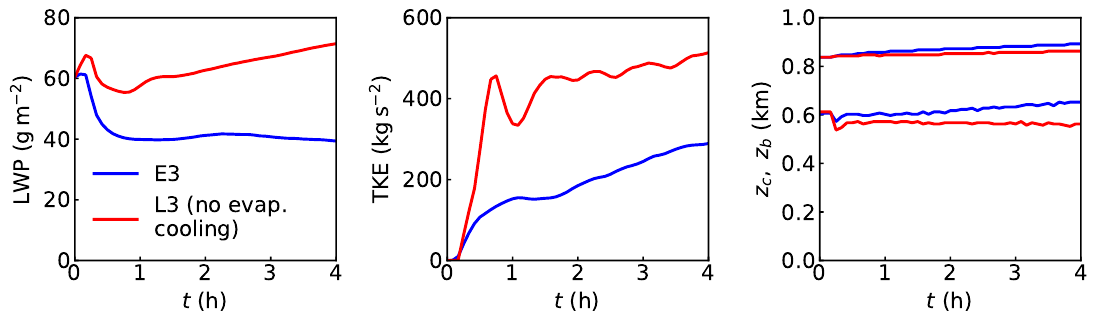
Figure 12. Time traces of liquid water path ( left panel), vertically integrated turbulent kinetic energy (middle panel), and cloud base and cloud top height for Cases E3 and L3 ( right